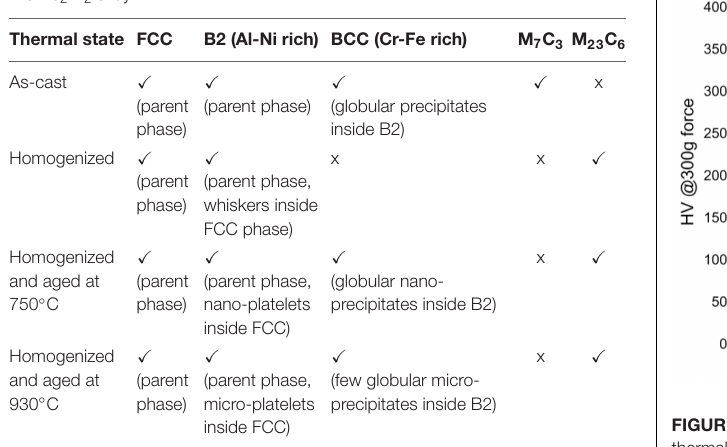
FIGURE 15 | Vickers microhardness test results of AlCrFe 2 Ni 2 alloy in various thermal